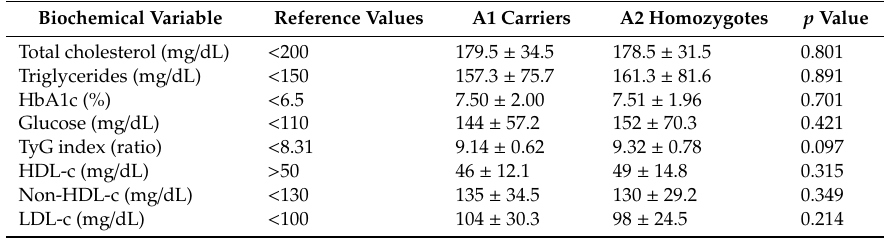
Table 4. Biochemical profile according to genotypes of the DRD2 / ANKK1 TaqIA